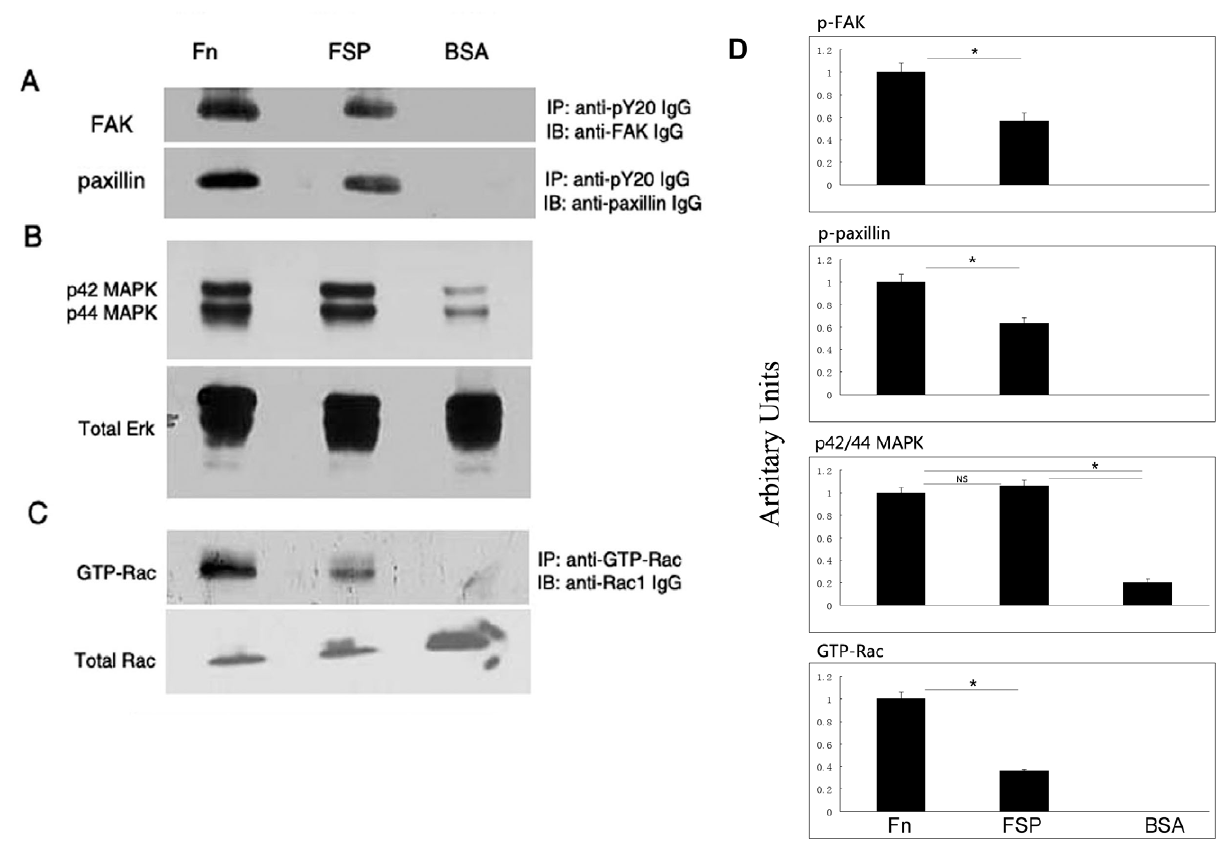
Figure 7. FSP induces phosphorylation of FAK, paxillin, and ERK1/2, and activates the small GTPase Rac in LEC. LEC cultured in serum- free DMEM for 48 hr were plated on dishes precoated with Fn, FSP, or BSA for 1 hr at 37 u C. Cell lysates were prepared. ( A ), immunoprecipitation of total cell lysates was performed with an anti-pY20 antibody followed by immunoblotting with anti-FAK IgG or anti-paxillin IgG. ( B ), Total cell lysates were immunoblotted with anti-phospho-Erk-1 (p42 MAPK) and anti- phospho-Erk-2 (p44 MAPK). Subsequently, the membrane was stripped and re- probed with anti-Erk IgG (total Erk). ( C ), Total cell lysates were incubated with anti-GTP-Rac IgG; activated Rac was affinity-precipitated and subsequently immunoblotted with IgG against Rac. An aliquot of cell lysate from each sample was immunoblotted for total Rac protein. ( D ) The histogram on the right shows results of scanning densitometry of p-FAK, p-paxillin, p42/44 MAPK, and GTP-Rac of three experiments with mean + / 2 SD. Data were normalized to the loading control and were plotted relative to Fn levels. * P , 0.05; NS, not significant. adhesion: the FSP-coated wells showed no difference in cell adhesion with or without anti-integrin antibodies (data not shown).